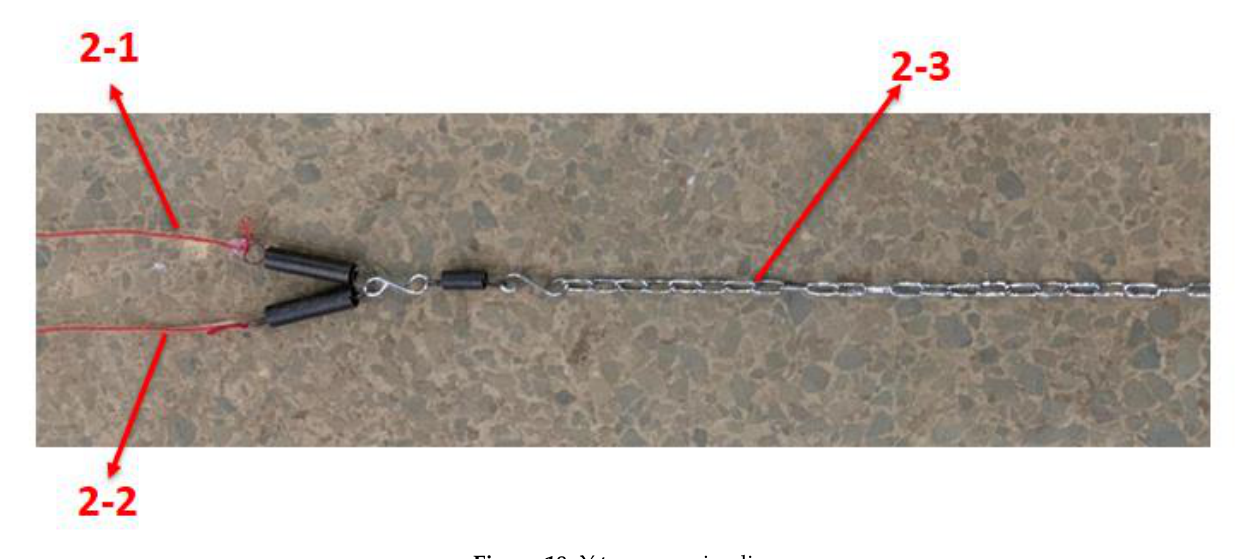
Figure 18. Y-type mooring line. Table 2. Mooring line parameters of material properties.